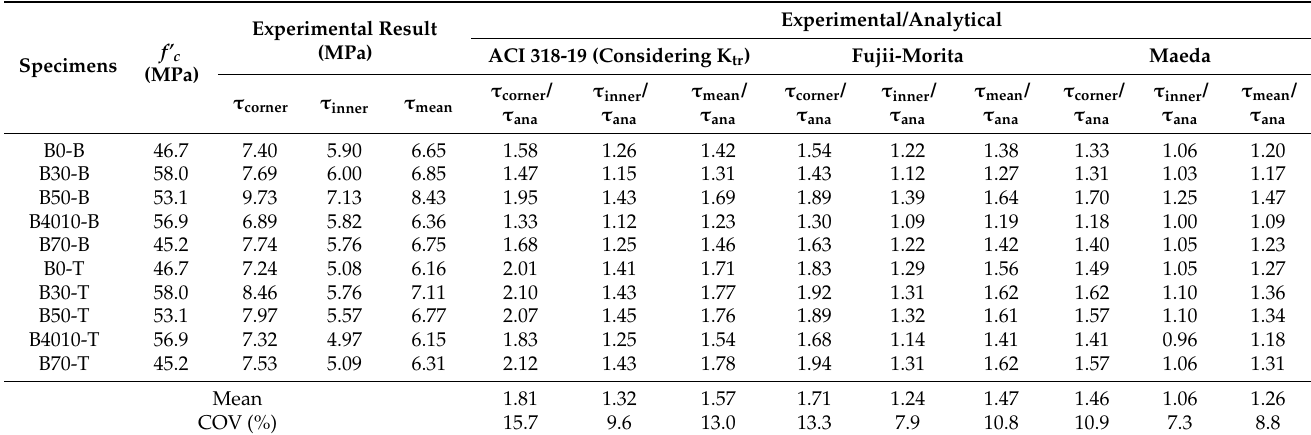
Figure 12. Measuring method of slip. As shown in Figures 11 and 13, regardless of the replacement ratio of ground granu ‐ lated blast furnace slag, flexural cracks were found in the B series specimens at the crack ‐ inducing grooves located at the boundary of the experimental zone in the early stage of the loading. As the load increased, flexural cracks increased, and many bond cracks were found in the experimental zone. When the maximum bond stress was reached, slip of the